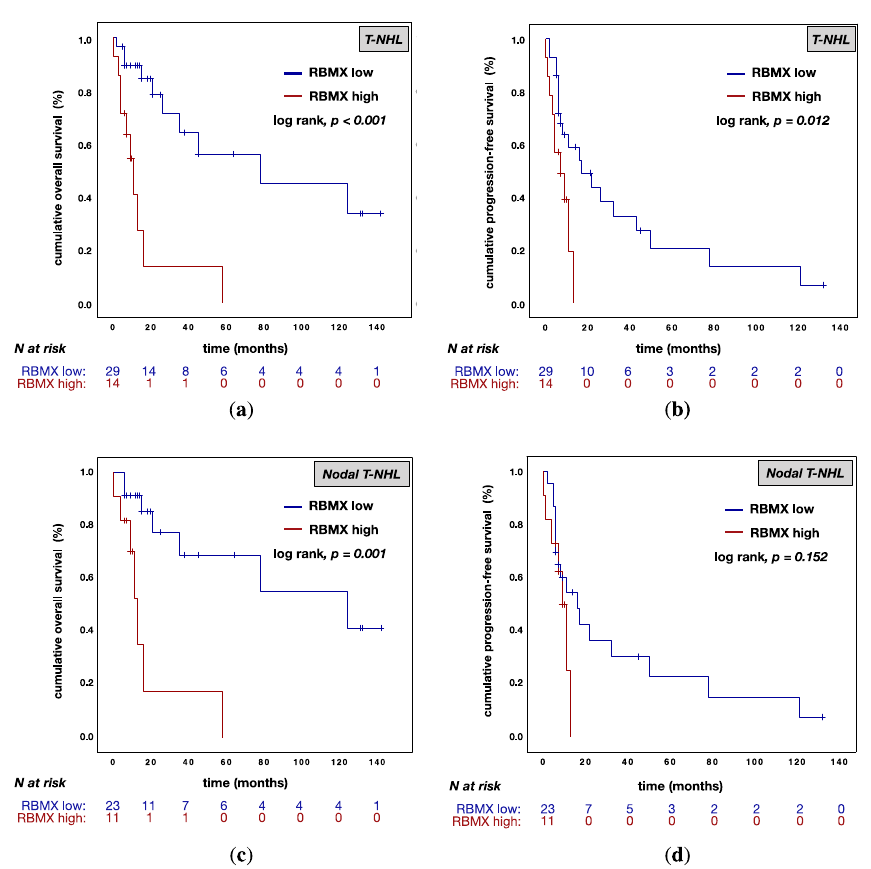
Figure 4. Kaplan − Meier (KM) curves for overall survival (OS) and progression-free survival (PFS) according to RBMX expression. ( a ): KM curve for OS according to RBMX expression in T-NHL; ( b ): KM curve for PFS according to RBMX expression in T-NHL; ( c ): KM curve for OS according to RBMX expression in nodal T-NHL: ( d ) KM curve of PFS according to RBMX expression in nodal T-NHL. Abbreviations: T-NHL: T-cell non-Hodgkin’s lymphomas; RBMX low: RBMX expression with an H-score below 175; RBMX high: RBMX expression above or equal to an H-score of 175; N : number of patients.